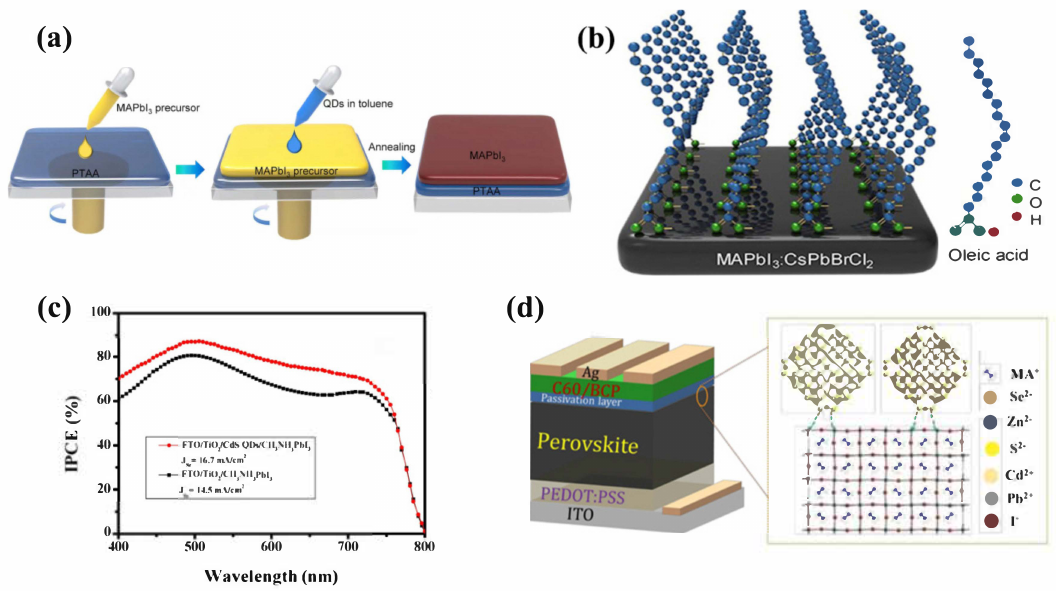
Figure 5. ( a ) Schematic illustration of the procedure for preparing MAPbI 3 film by using CsPbBrCl 2 QDs as an anti-solvent suspension. Reproduced from [84], with permission from Elsevier, 2019. ( b ) Schematic representation of the uniform distribution of elements in MAPbI 3 film and the self- assembly of OA molecules on the surface of MAPbI 3 film. Reproduced from [84], with permission from Elsevier, 2019. ( c ) IPCE spectra of TiO 2 /MAPbI 3 (black line) and TiO 2 /CdS/MAPbI 3 (red line) solar cells. Reproduced from [93], with permission from Elsevier, 2018. ( d ) Schematic of the structure of CdSe/ZnS QDS-based device. Reproduced from [95], with permission from Royal Society